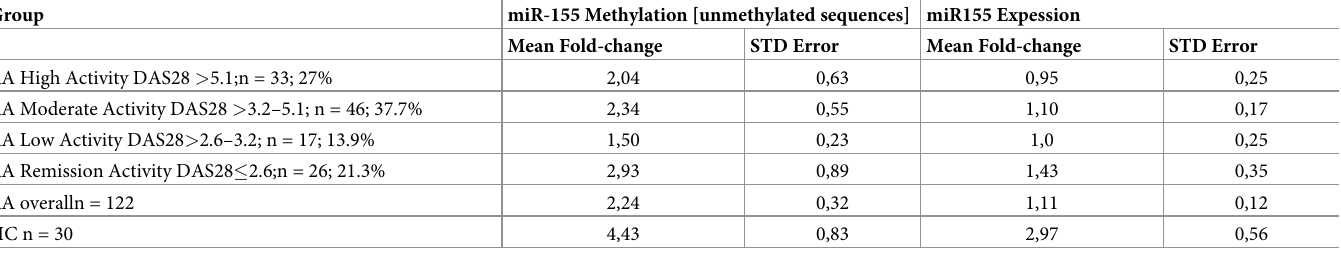
Table 2. Methylation level of miR-155 gene (shown as unmethylated sequences) and miR-155 plasma expression in RA group (divided according DAS28 activity) and in HC.